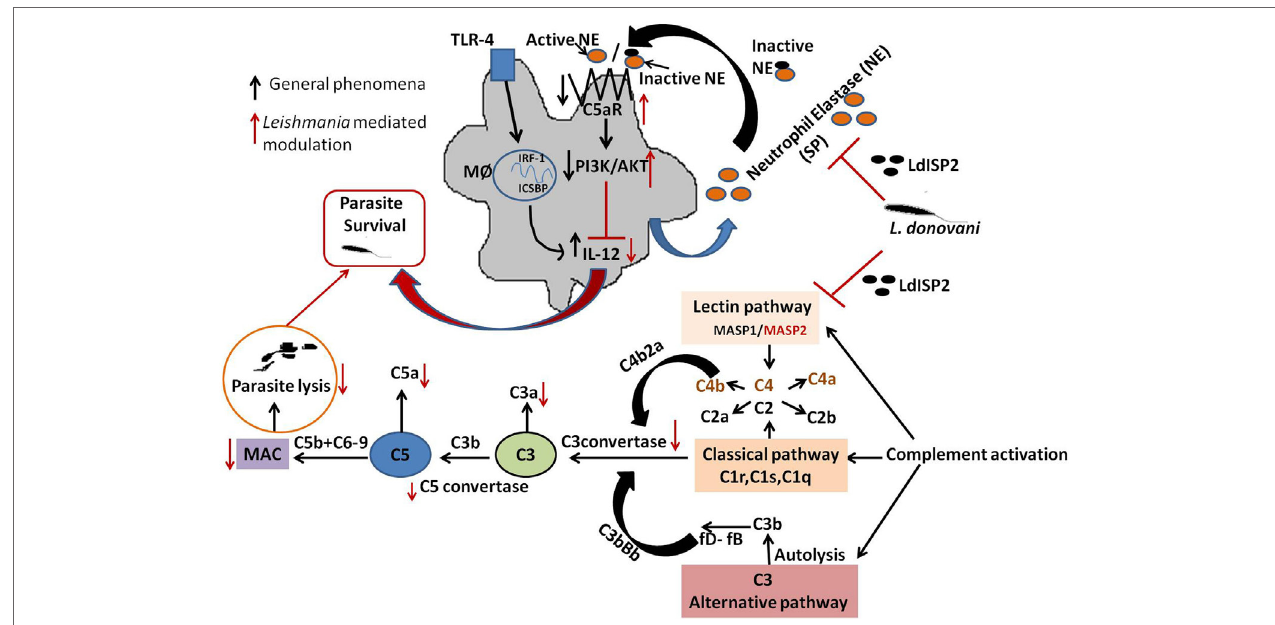
FigUre 11 | Schematic representations demonstrating the role LdISP2 in the modulation of host response. The model illustrates that the survival of Leishmania donovani parasites inside host depends on their capacity to resist the complement attack and to modulate the host immune response by using LdISP2. In one way, Leishmania ISP2 inhibit the activation of lectin pathway by interaction with MASP2. Inhibition of MASP2 by LdISP2 results in less production of C3 and C5 convertase leading to decreased membrane attacking complex (MAC) formation. Reduced MAC formation decreases complement-mediated lysis of the parasites. In this way, the Leishmania parasites defend itself from complement-mediated attack by using LdISP2. On another way, LdISP2 inhibits utrophil elastase (NE) activity and upregulate C5aR expression. Induced expression of C5aR activates the PI3K/AKT pathway. Phosphorylation of PI3K/AKT decreases IL-12 level. L. donovani utilises theses two different strategies for its own survival by using LdISP2. The black arrow indicates the normal phenomena and the red arrow indicates the phenomena modulated by L. donovani